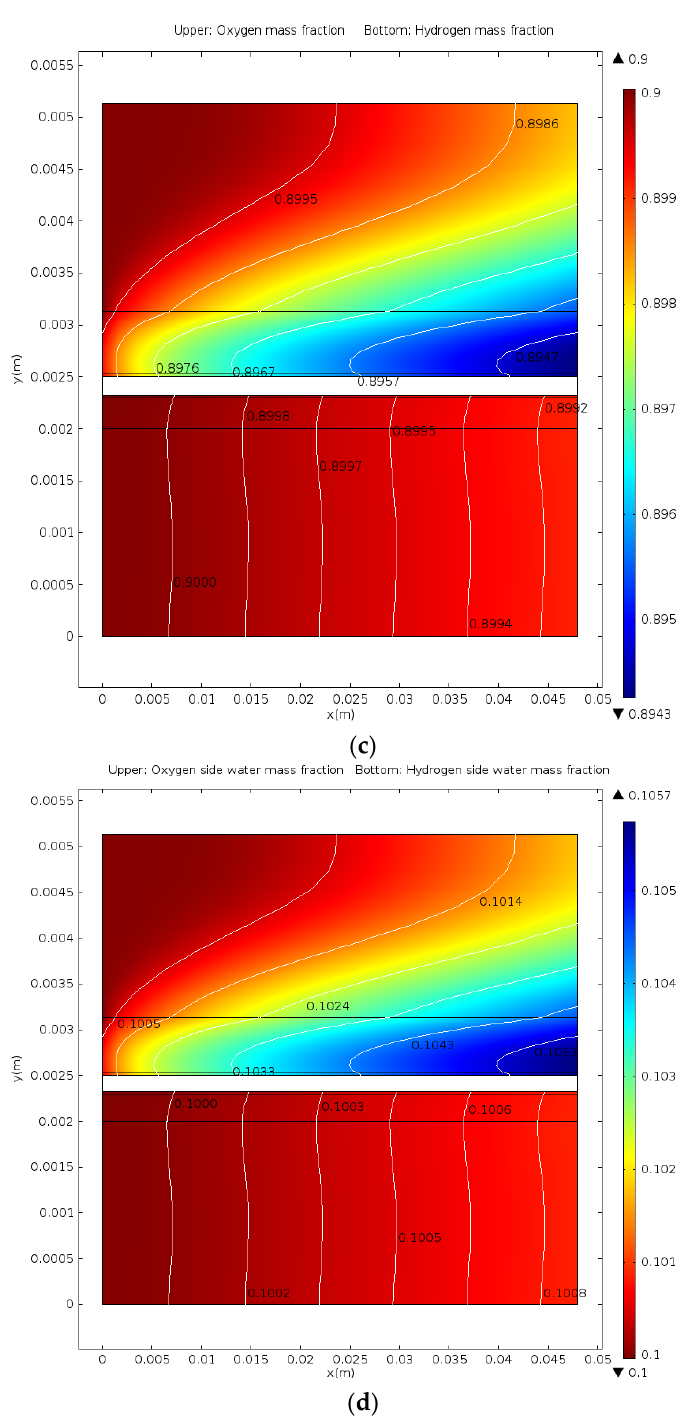
Figure 10. ( a ) Distributions of O 2 and H 2 mass fractions at − 0.01 s; ( b ) Distributions of H 2 O mass fractions at − 0.01 s; ( c ) Distributions of O 2 and H 2 mass fractions at 0.01 s; ( d ) Distributions of H 2 O mass fractions at 0.01 s.